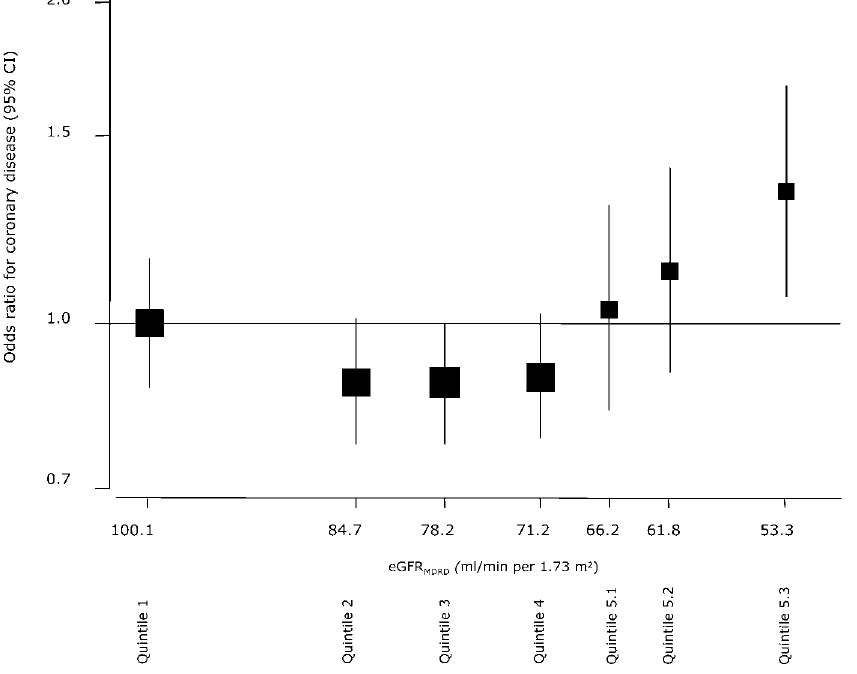
Figure 2. Association between Estimated Baseline GFR and CHD Adjusted for Age, Sex, Period, Smoking Status, and Other Established Risk Factors eGFR was calculated using Modification of Diet in Renal Disease equation. The size of the data markers is proportional to the inverse of the variance of the ORs. 95% CIs are calculated using floating-variance. Established risk factors included total cholesterol, triglycerides (log transformed), systolic blood pressure, and BMI. eGFR MDRD , overall v 2 with 6 df ¼ 14.6, p ¼ 0.02. doi:10.1371/journal.pmed.0040270.g002 PLoS Medicine |